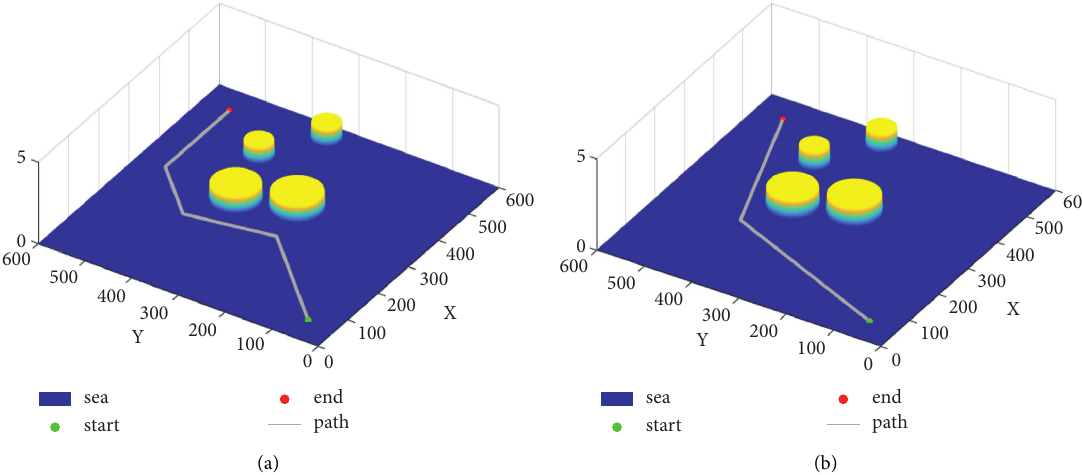
Figure 11: Comparison of the path optimized by the DP algorithm and the path optimized by the improved DP algorithm. (a) Path optimized by DP algorithm. (b) Path optimized by improved DP